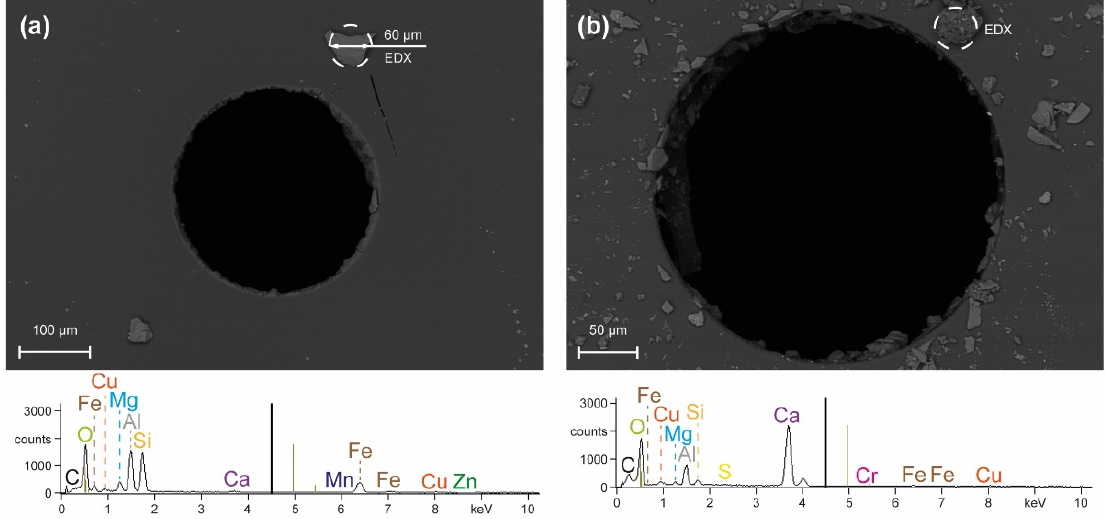
Figure 10. SEM images with an EDX measurement of ( a ) a particle near a crack and ( b ) a particle on the surface of the orifice jewel.